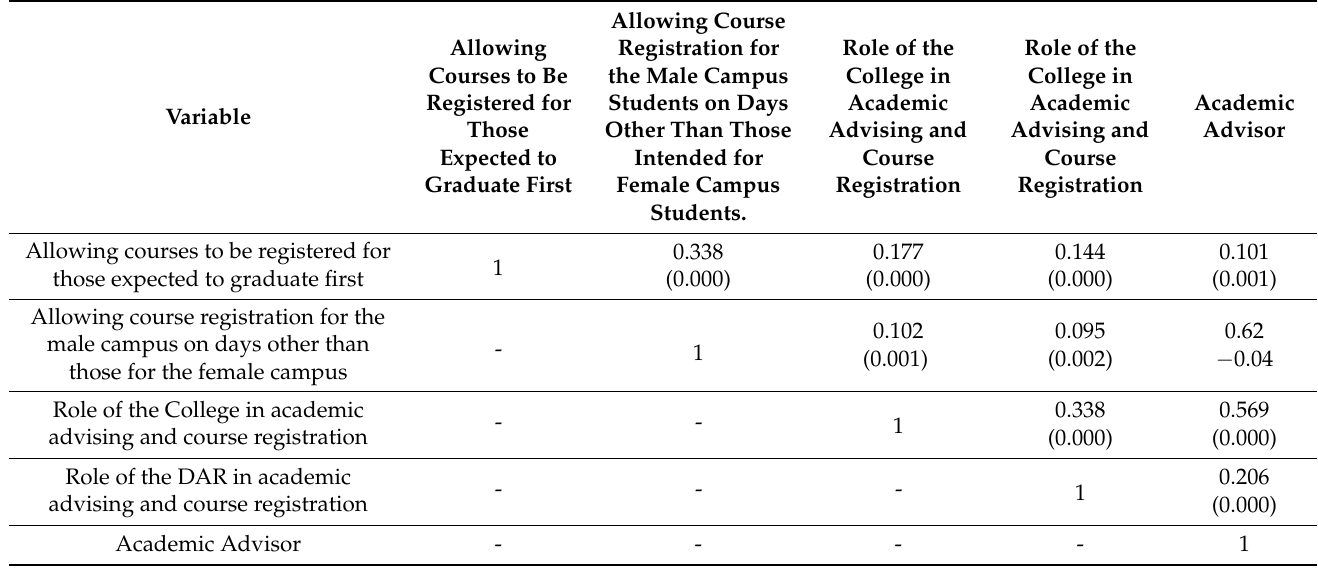
Table 24. The correlation matrix between the five study